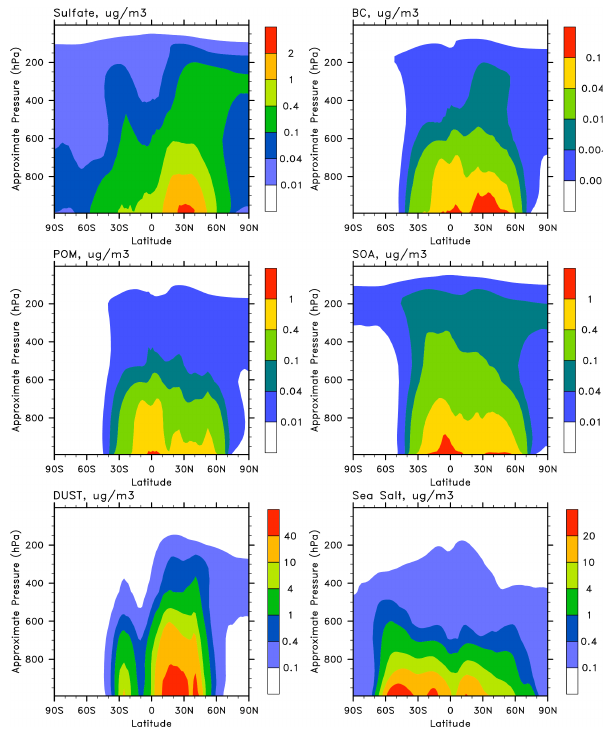
Figure 4. Annual and zonal mean distributions of sulfate, BC, POM, SOA, dust and sea salt concentrations in MAM3.